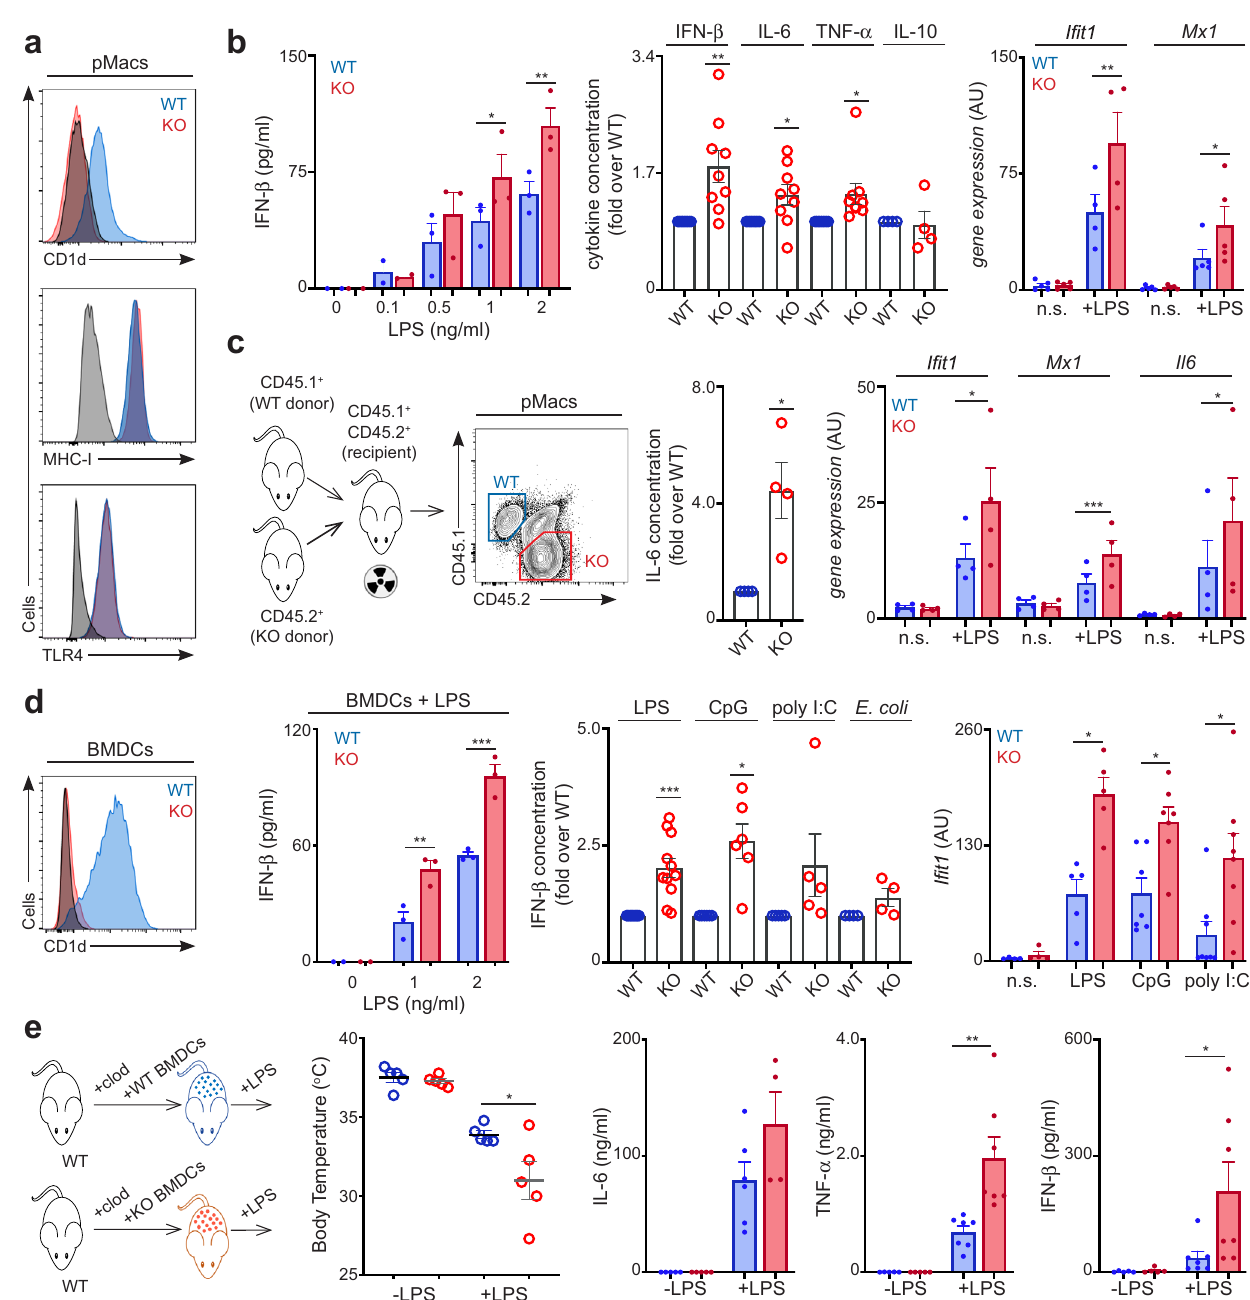
Fig. 1 | A cell-intrinsic function for CD1d in the regulation of TLR responses. a , b Peritoneal macrophages (pMacs) were obtained from WT and CD1d-KO mice. a Representative fl ow cytometry of WT (blue) and CD1d-KO (red) pMacs showing expression of the depicted markers in steady state. b Secretion of IFN- β (left, n =2 – 3), normalised concentration of secreted cytokines (fold over WT, middle, n =4 – 9) and gene expression (right, n =4 – 5) in WT and CD1d-KO pMacs cultured with LPS for 6h. * p <0.05; ** p <0.01, 2-way ANOVA (left), one-sample (middle) or two-tailed paired t -test (right). n.s.=non-stimulated. c Mixed BM chimeras (WT:CD1d-KO; 50:50) were generated by co-transferring WT (CD45.1 + ) and CD1d- KO (CD45.2 + ) BM into irradiated recipients (CD45.1 + CD45.2 + ). WT and KO pMacs were sort-puri fi ed from chimeric mice and stimulated with LPS. Normalised con- centrationofIL-6(foldoverWT,left, n =4)andgeneexpressionmeasuredbyqPCR (right, n =4) are shown. * p <0.05; *** p <0.001, one-sample (left) or two-tailed paired t -test(right).n.s.=nonstimulated. d GM-CSFculturedbone-marrowderived